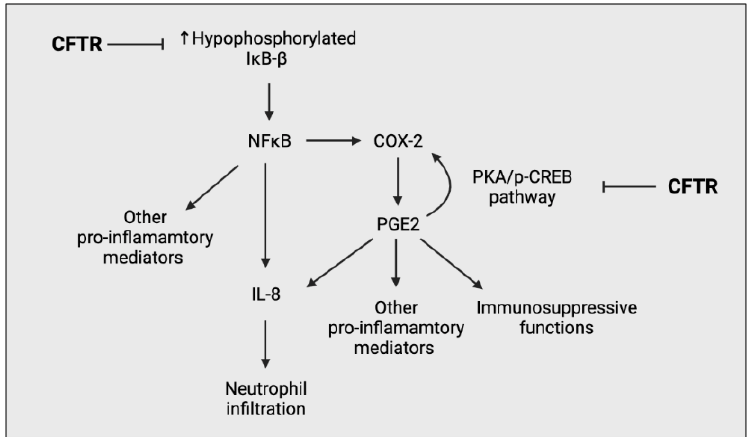
Figure 4. Simplified schematic outlining the ability of CFTR to negatively regulate the pro-inflammatory response of airway epithelial cells. CFTR prevents the overproduction of hypophosphorylated IκΒ-β, preventing the overactivation of the NFκΒ pathway. CFTR also negatively regulates the PGE 2 -mediated cyclooxygenase-2 (COX-2) positive feedback loop, preventing the excessive production of prostaglandin (PG) E2.